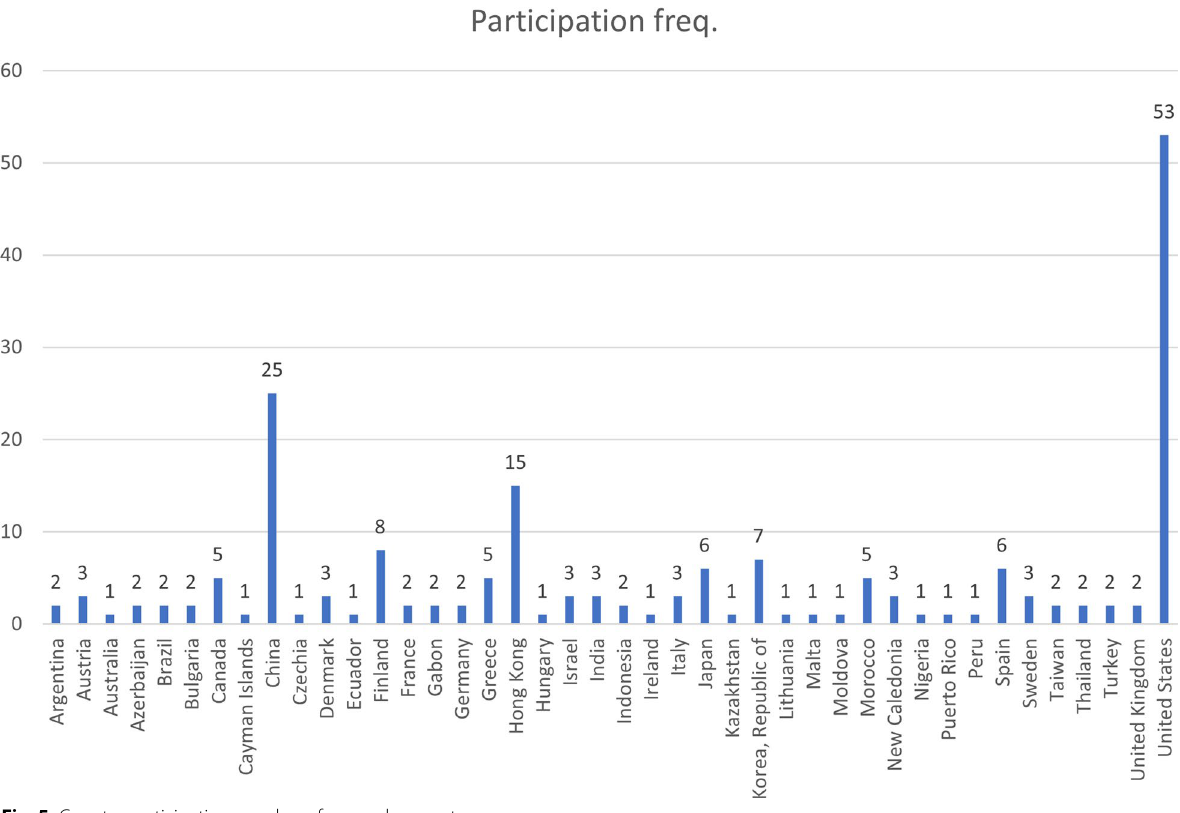
Fig. 5 Country participation: number of papers by country